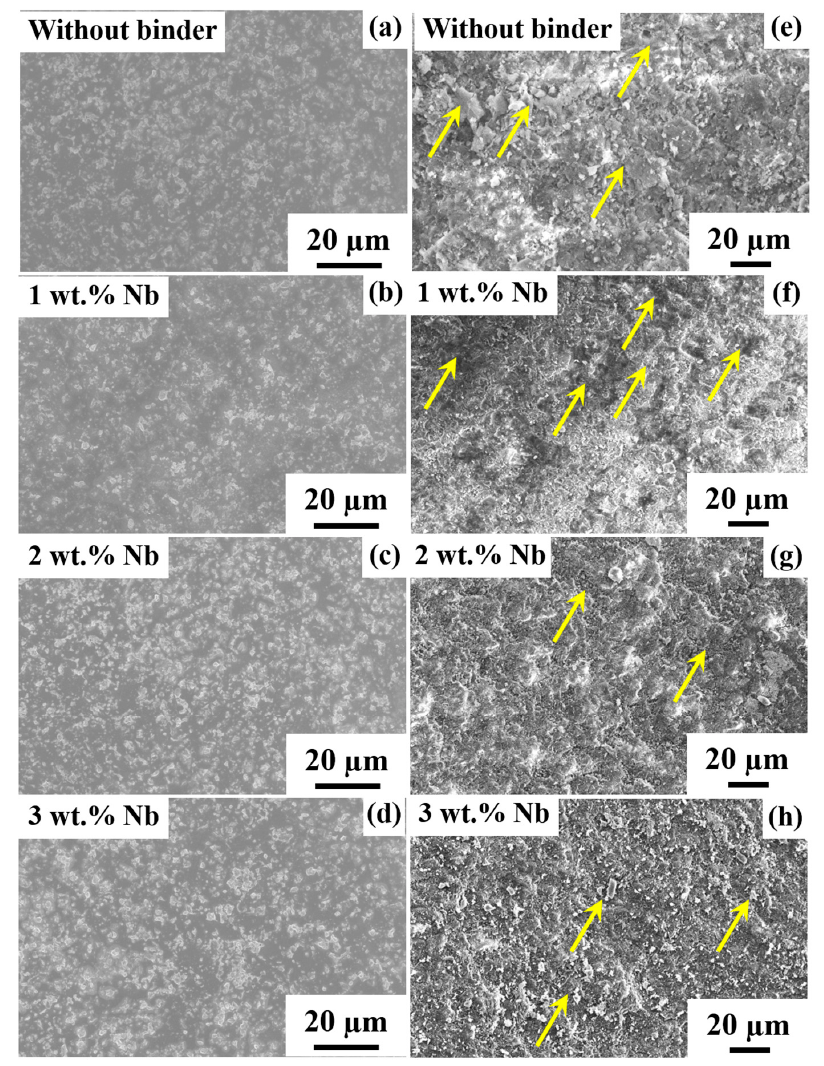
Figure 6. FESEM micrographs of the Al 2 O 3 -10TiC composite samples without Nb and with different contents of Nb ( a – d ) before and ( e – h ) after abrasion test.